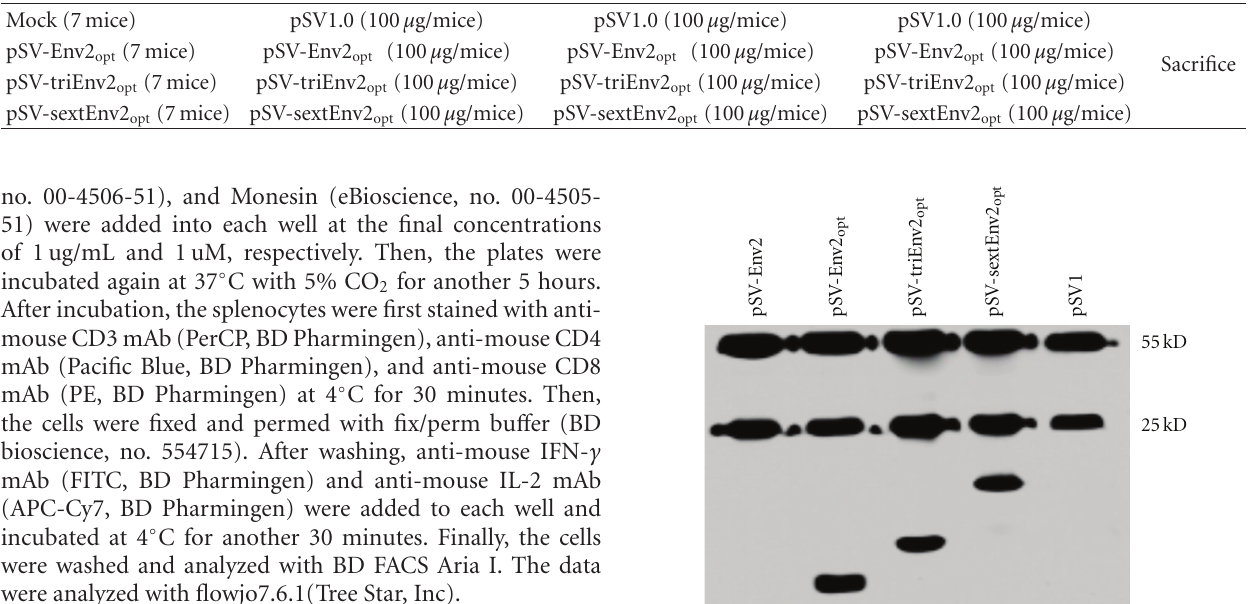
Table 1: Vaccination schedule of mice. All mice were intramuscularly inoculated with DNA vaccines. Group